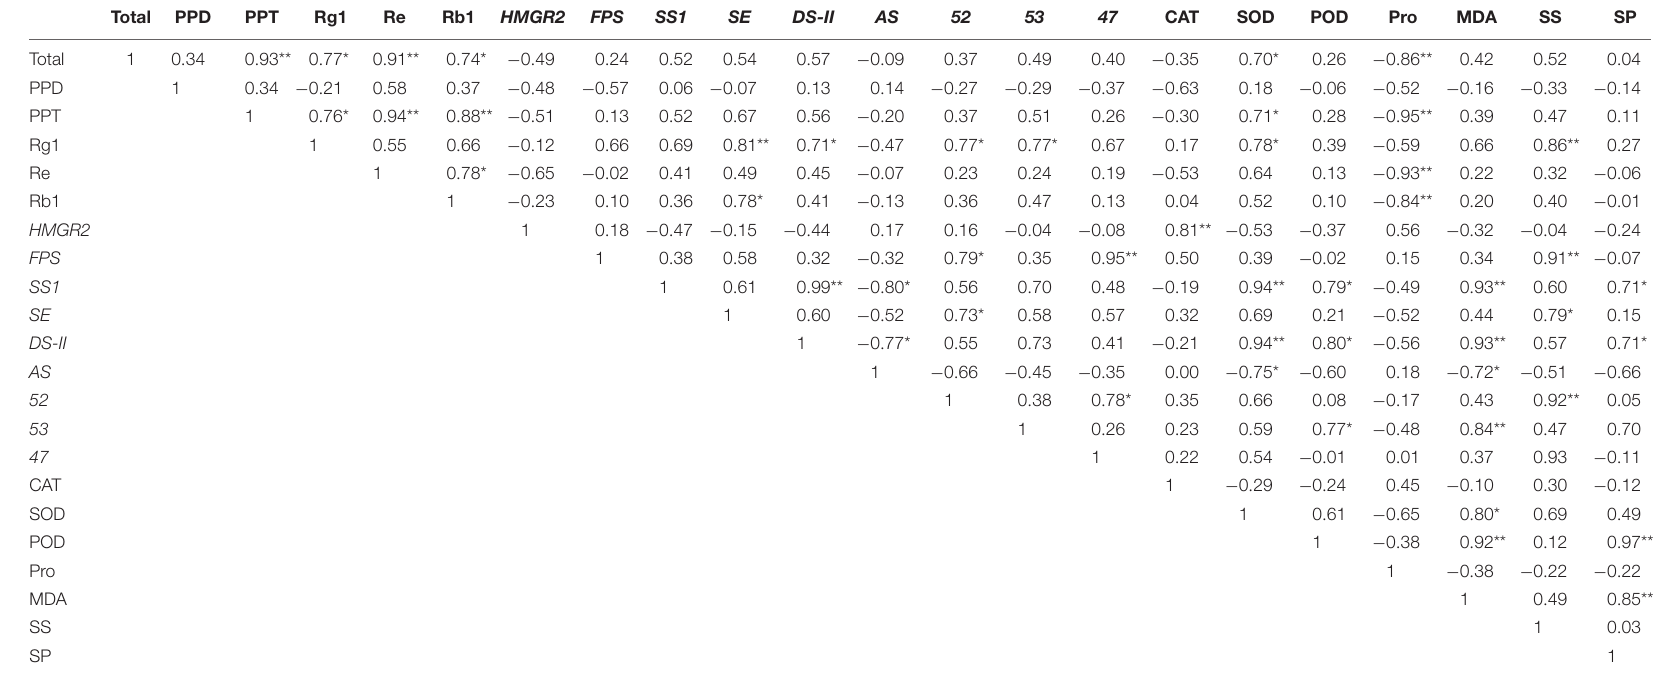
TABLE 4 | Correlation analysis among ginsenosides, physiological stress indicators, and secondary metabolism in plants under cold stress.